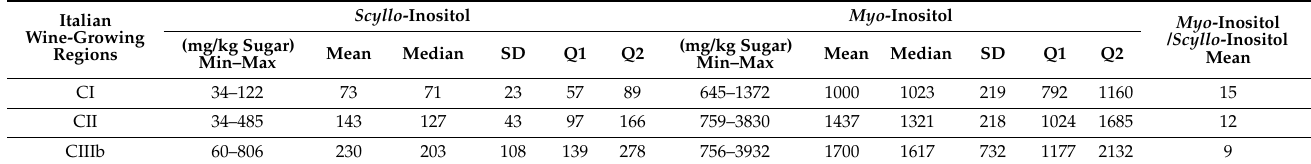
Table 4. Lower and higher concentrations, mean, median, standard deviation (SD), first quartile (Q1), and third quartile (Q3) of myo - and scyllo -inositol and mean values of the myo -inositol/ scyllo